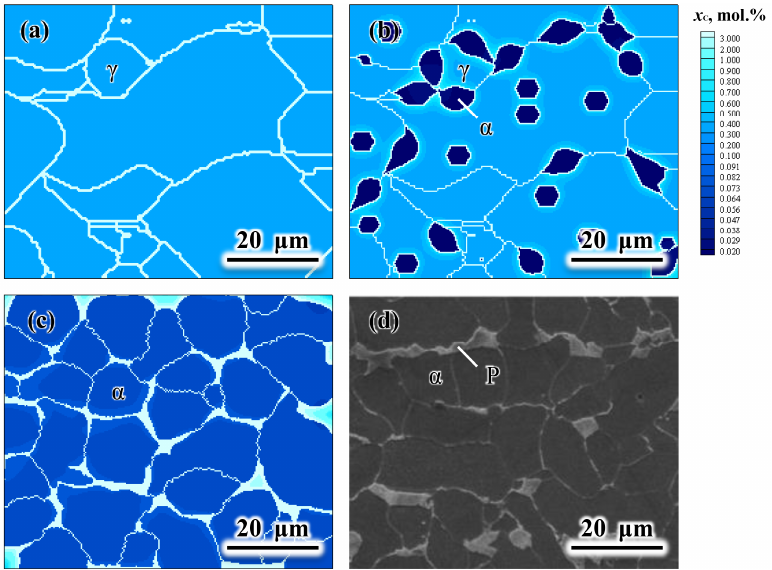
Figure 8. CA-simulated microstructures and carbon concentration fields during cooling from 832 °C to 650 °C at a cooling rate of 4 °C s −1 : ( a ) T = 832 °C; ( b ) T = 750 °C; ( c ) T = 650 °C ( t = 45.5 s, f α = ~0.92, D α = ~9.4 μm); ( d ) SEM micrograph ( f α = ~0.93, D α = ~9.7 μm) of the cooled sample at room temperature. f α is the α volume fraction, and D α is the average diameter of α-grains.